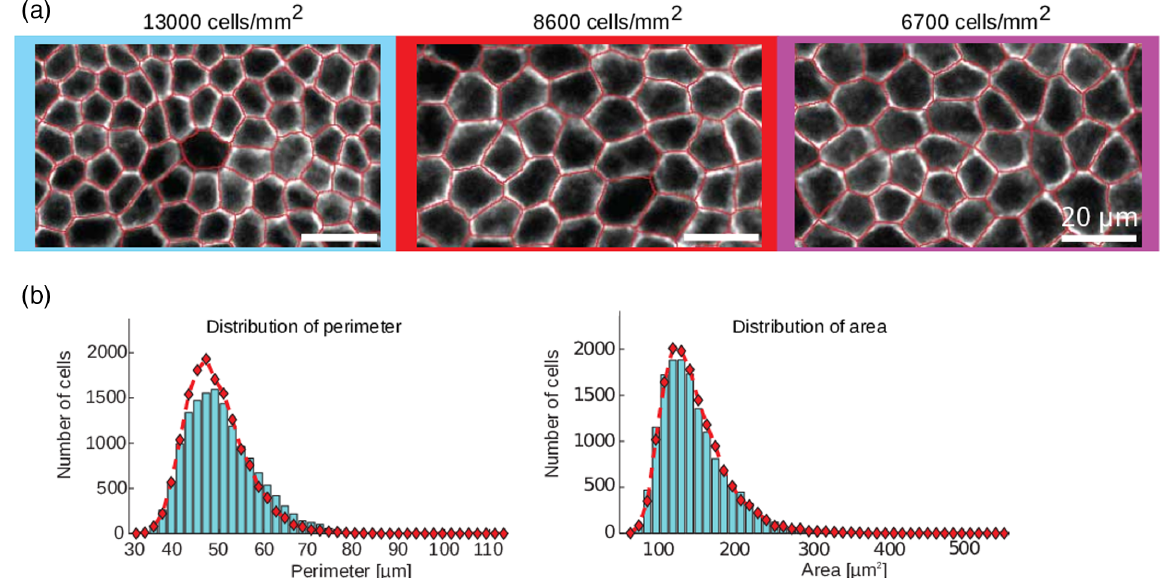
FIG. 9. Morphological analysis of the tissue. (a) Comparison between pictures of the cell membranes stained with β -catenin and the set-based Voronoi tessellation (in red). (b) Distribution of cell perimeters and areas, respectively, measured by pictures of β -catenin stained membranes (bars) and by SVT (red diamonds) for cells grown on hard 11 kPa gels. These distributions comprise cells from all compartments of the tissue, including the edge compartments. Prior to the comparison, all segmented images of β -catenin and nuclei have been hand corrected for errors, as described in Refs. [38,73].